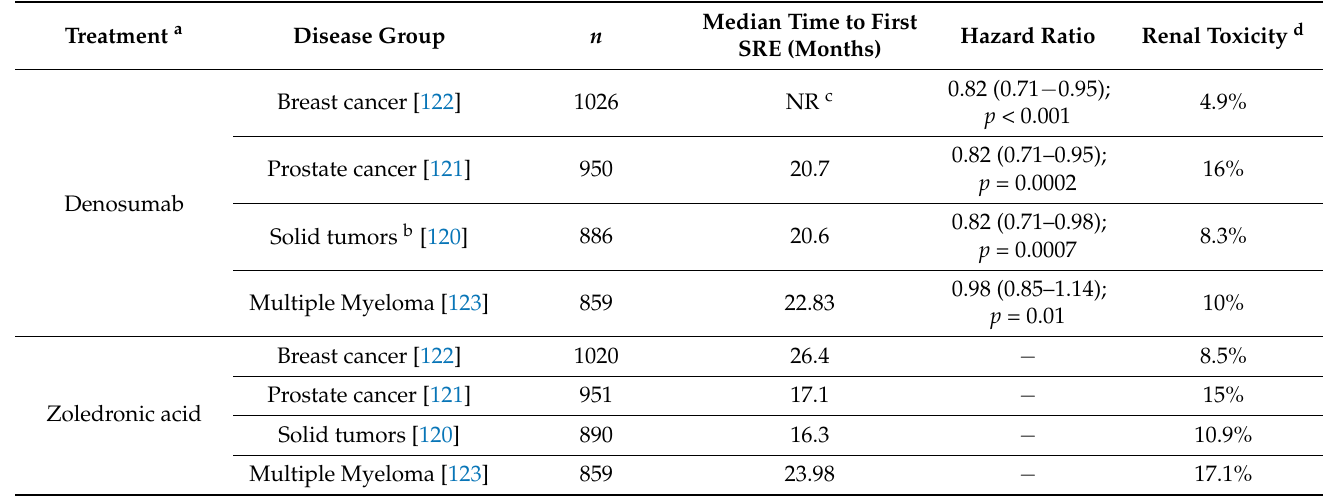
Table 1. Phase III randomized studies of denosumab versus zoledronic acid in solid and hematologic